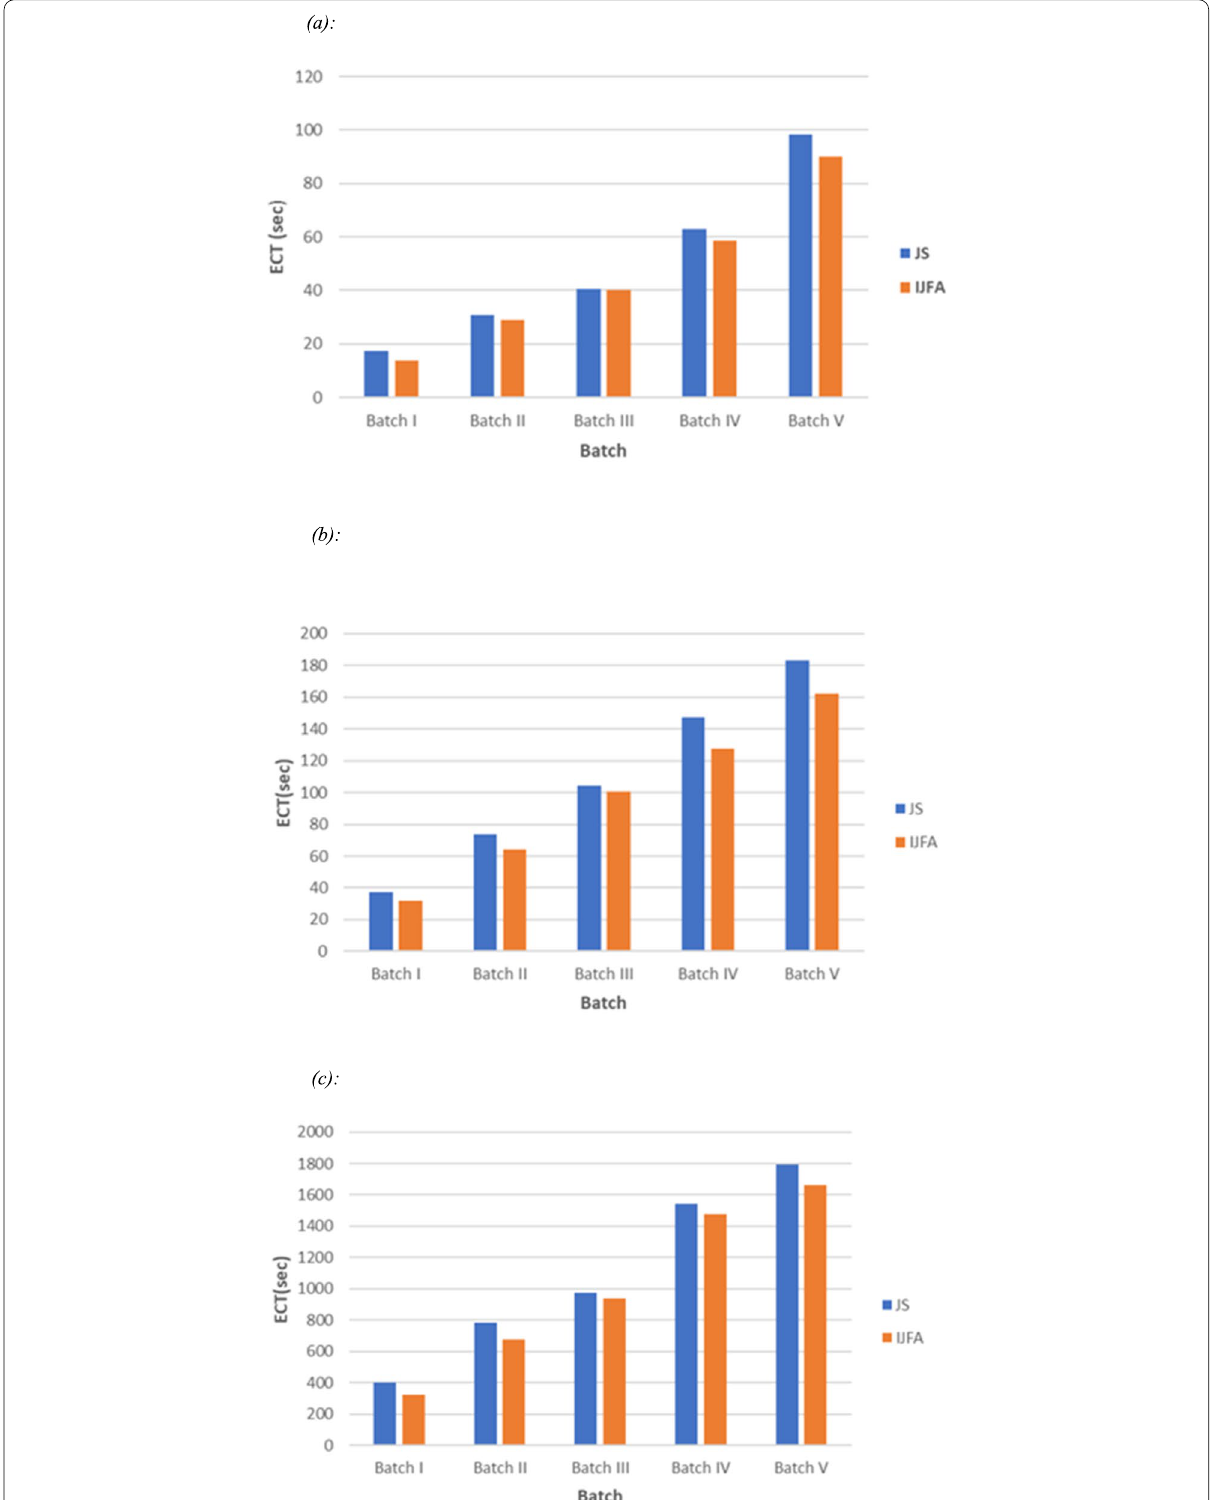
Fig. 8 a ECT v/s Batch Size for JS and IJFA for the Fog Integrated Cloud Architecture. b ECT v/s Batch Size for JS and IJFA for the Cloud Only Architecture. c ECT v/s Batch Size for JS and IJFA for the Fog-Only